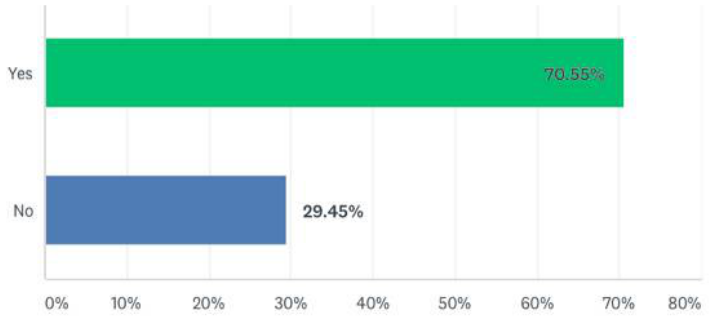
Figure 6. U.S. participants’ willingness to pay—sustainable tourism. Note: responses to the question